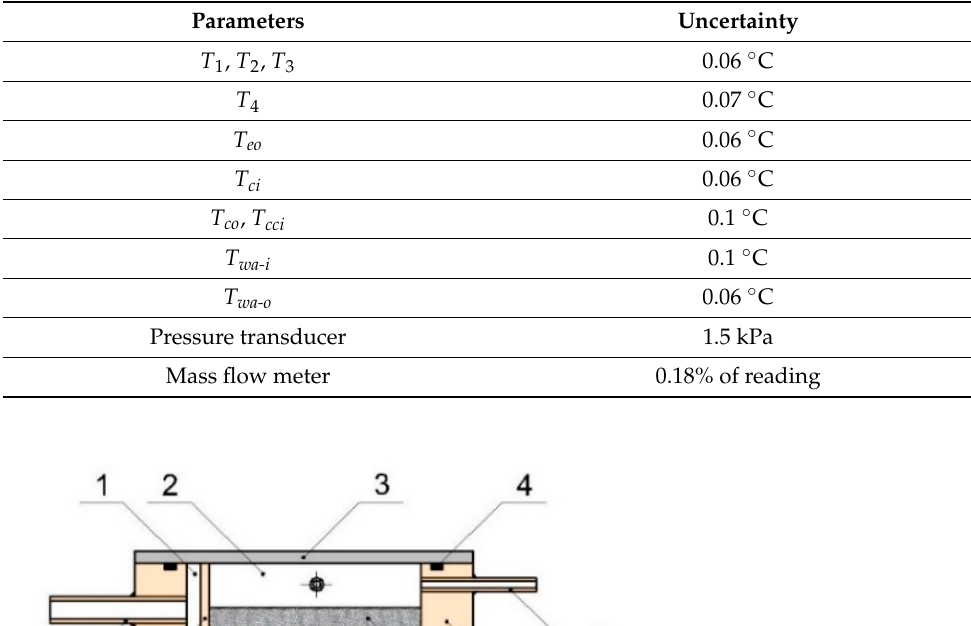
Table 4. Uncertainty values.